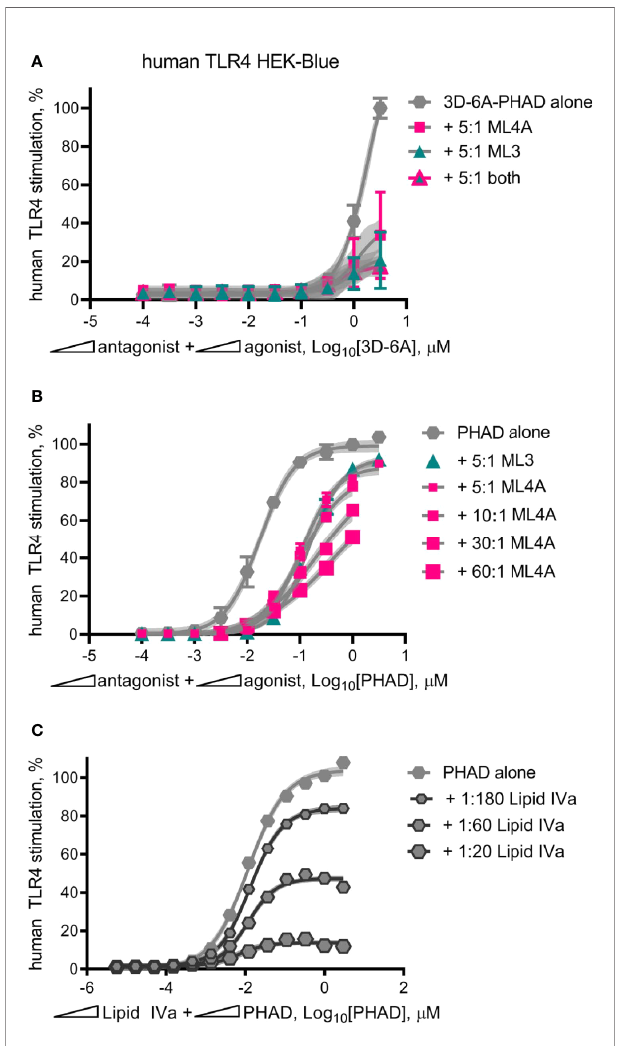
FIGURE 8 | Mixed agonist – antagonist dose pro fi les replicate the low dose plateau of MPL adjuvant ® . Dose curve pro fi les of agonist-antagonist mixtures at fi xed ratios were generated using human TLR4 reporter cells to determine whether the suppressed dose plateau of MPL adjuvant ® could be recapitulated with synthetic components. (A) 3D-6A-PHAD, as a surrogate for ML6, was mixed with either ML3, ML4A or both at a ratio of 5:1 antagonist: agonist and diluted in half-log steps from peak concentrations of [3.16 m M 3D-6A-PHAD + 15.8 m M antagonist]. Values ± SD shown are of secreted alkaline phosphatase from three independent experiments performed in duplicate and normalized by setting 100% = max value for 3D-6A-PHAD alone. (B) PHAD was mixed with ML4A at ratios of 5:1, 10:1, 30:1 or 60:1 antagonist:agonist and diluted in half-log steps from peak concentrations